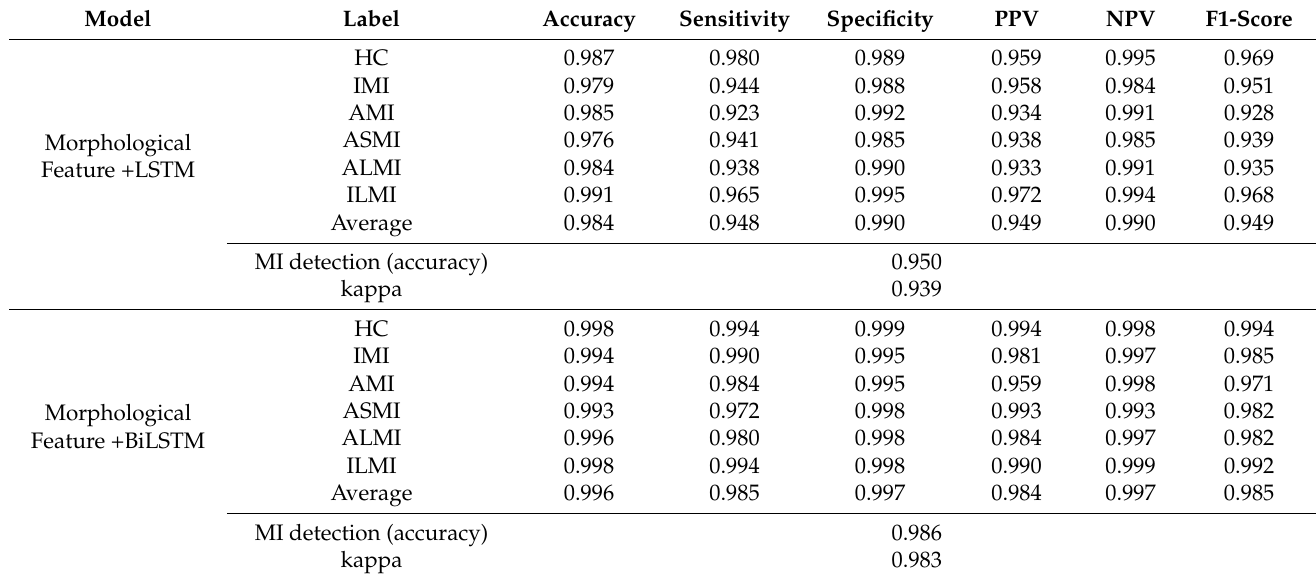
Table 6. MI localization results (abbreviations in the table are shown in Table